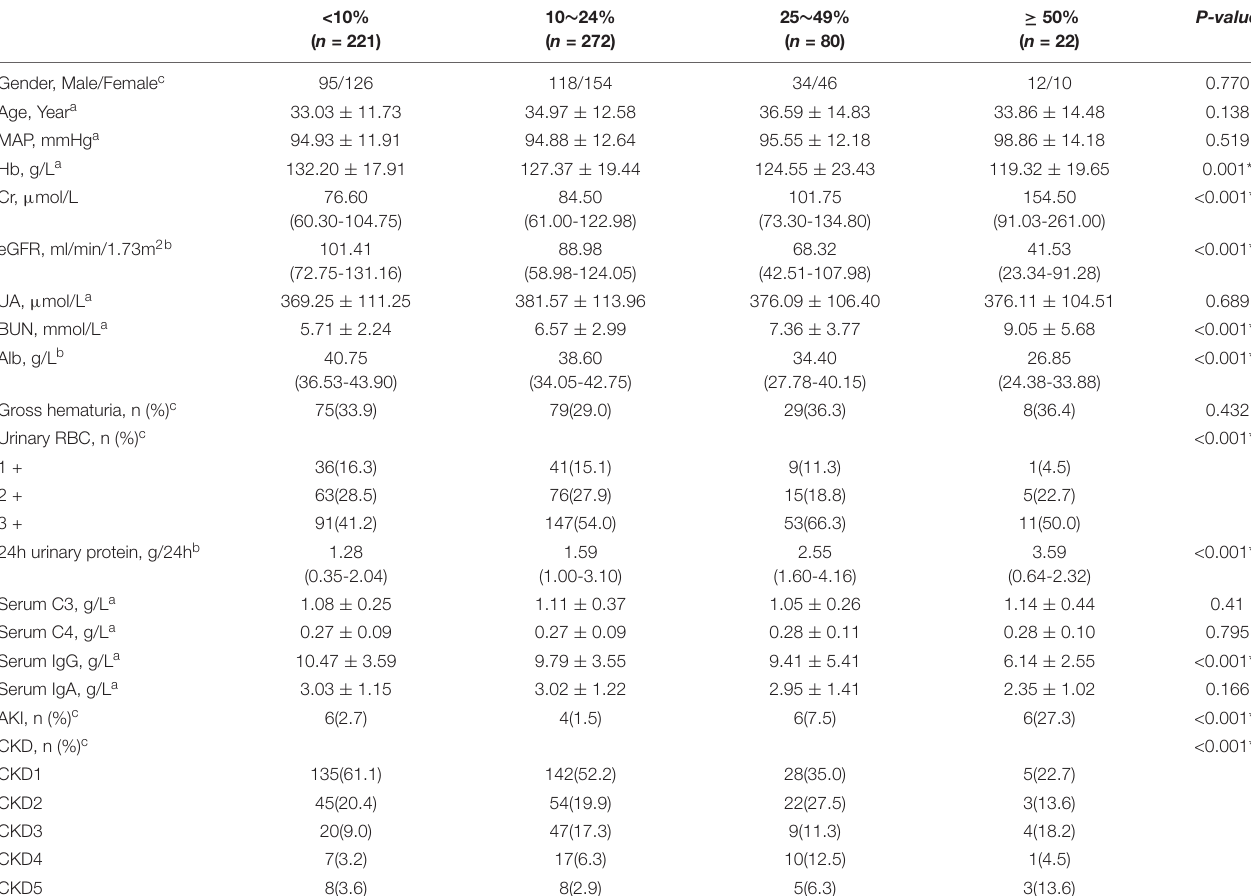
TABLE 1 | Baseline characteristics of IgAN patients with different proportions of